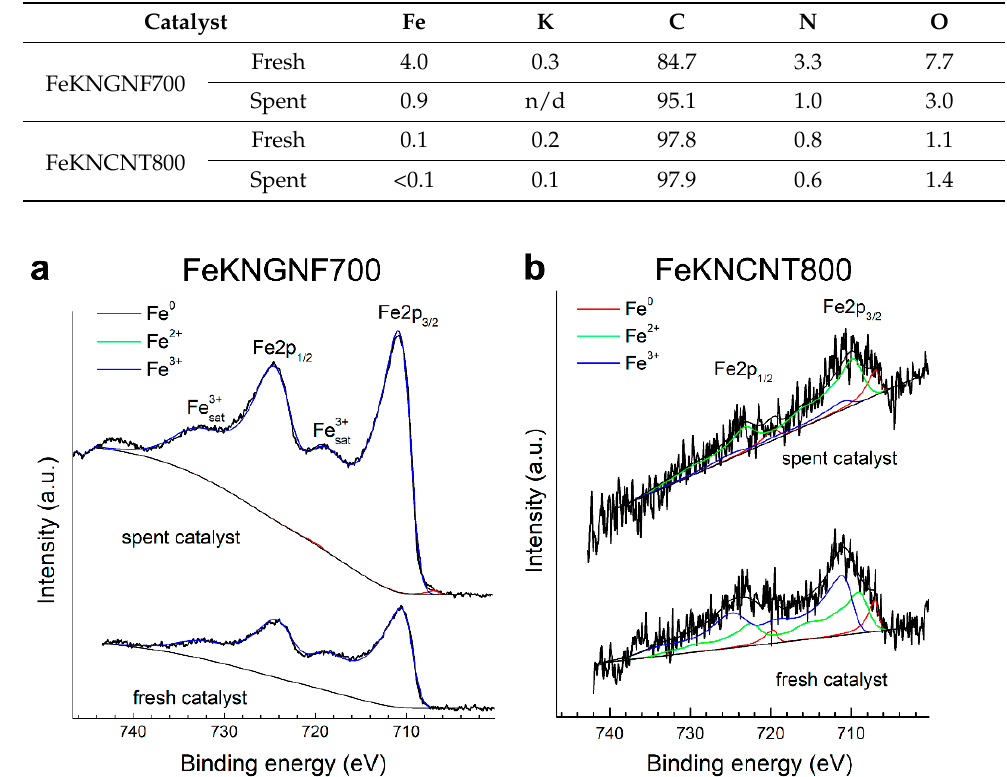
Table 4. The XPS surface compositions (at.%) of fresh and spent FeKNGNF700 catalysts.